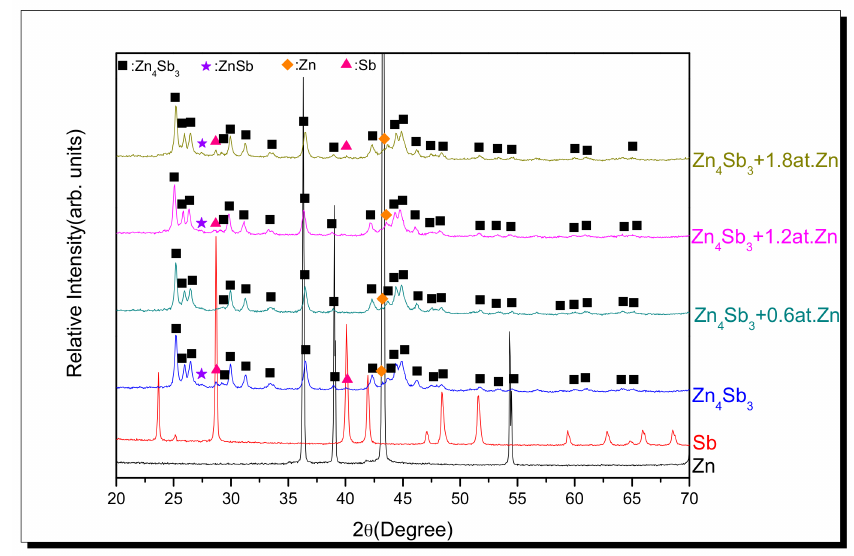
Figure 1. X-ray diffraction (XRD) patterns of mechanically alloyed powders with different Zn rich